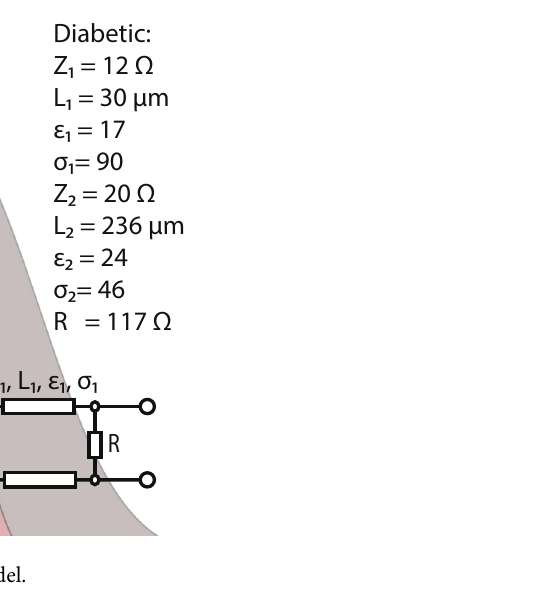
Figure 4. The proposed transmission line